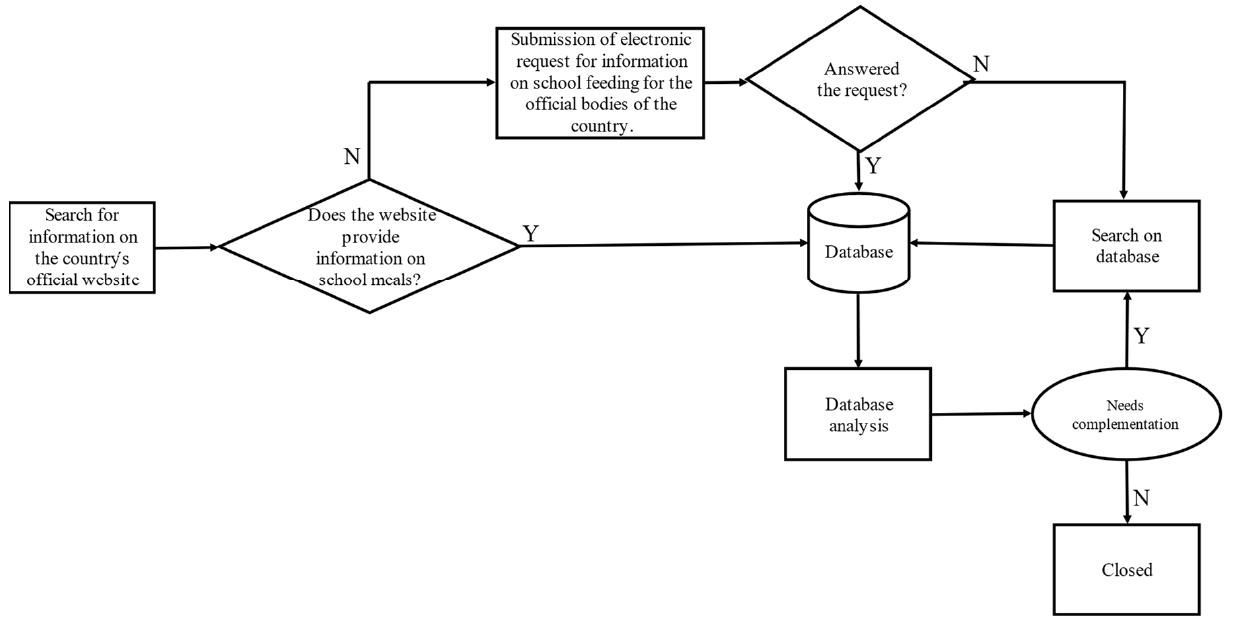
Figure 1. The flowchart of the steps developed for the documentary research.